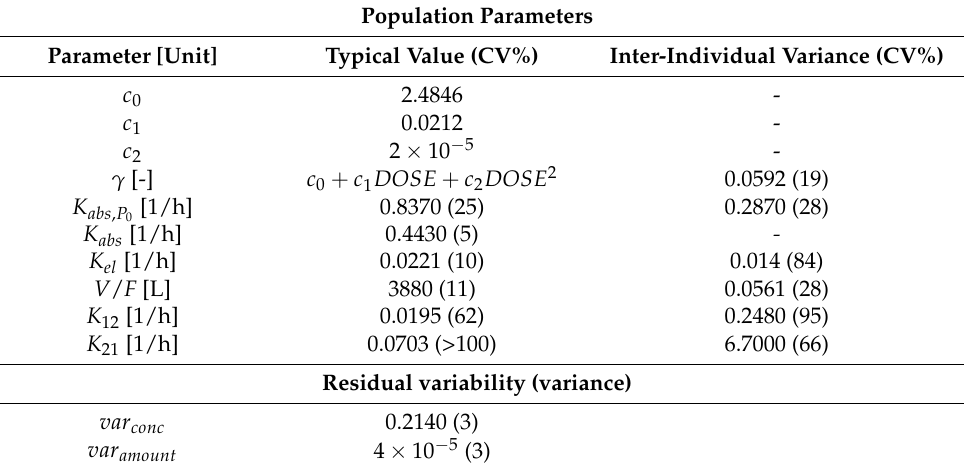
Table A1. Parameter estimates of the population IVIVC P-ring model on dose 125, 750, and 1500